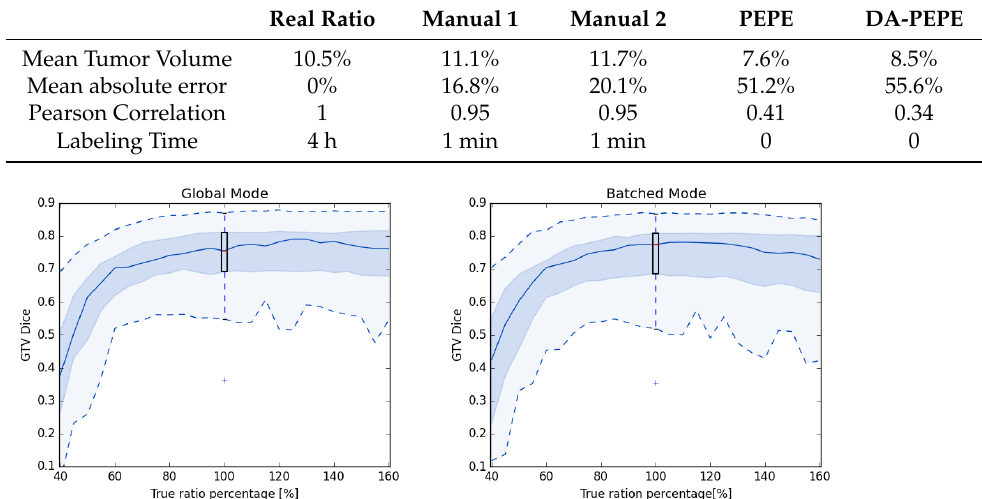
Table 1. Estimations of class prior π and the correlation between the reference ratio and the estimation.